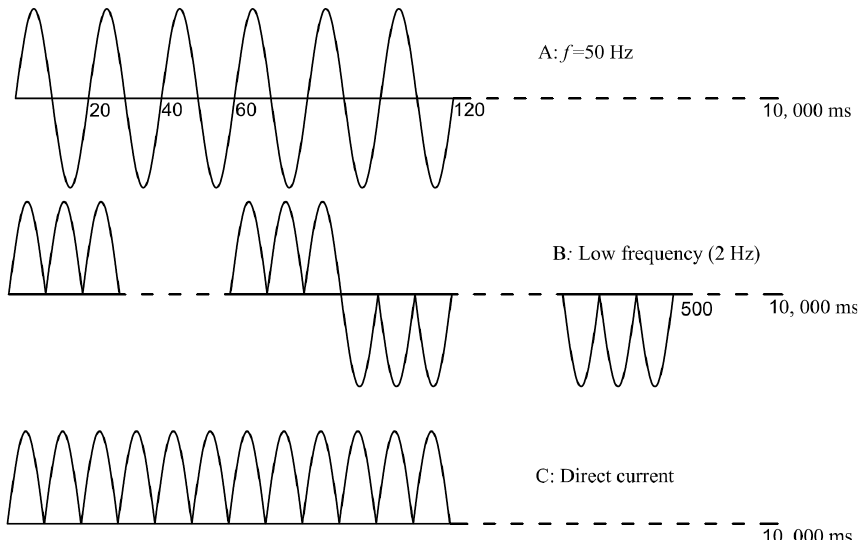
Figure 2. Waveform of different power supply modes.